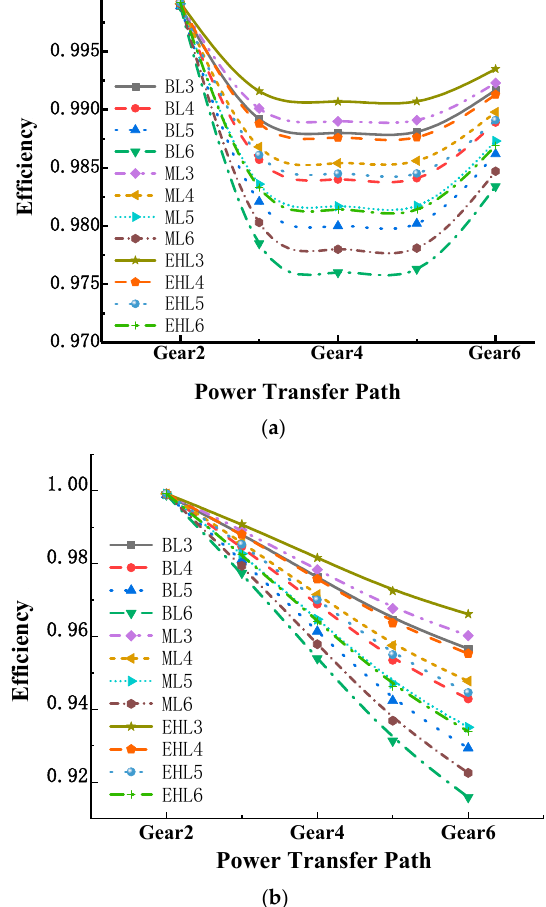
Figure 15. Transmission efficiency under different lubrication conditions. ( a ) Efficiency of each transmission element along the transmission path; ( b ) efficiency along the transmission path.